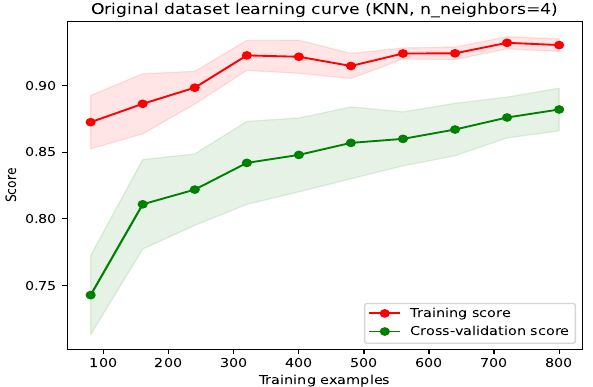
Figure 11. Original training set learning curve scatter diagram.